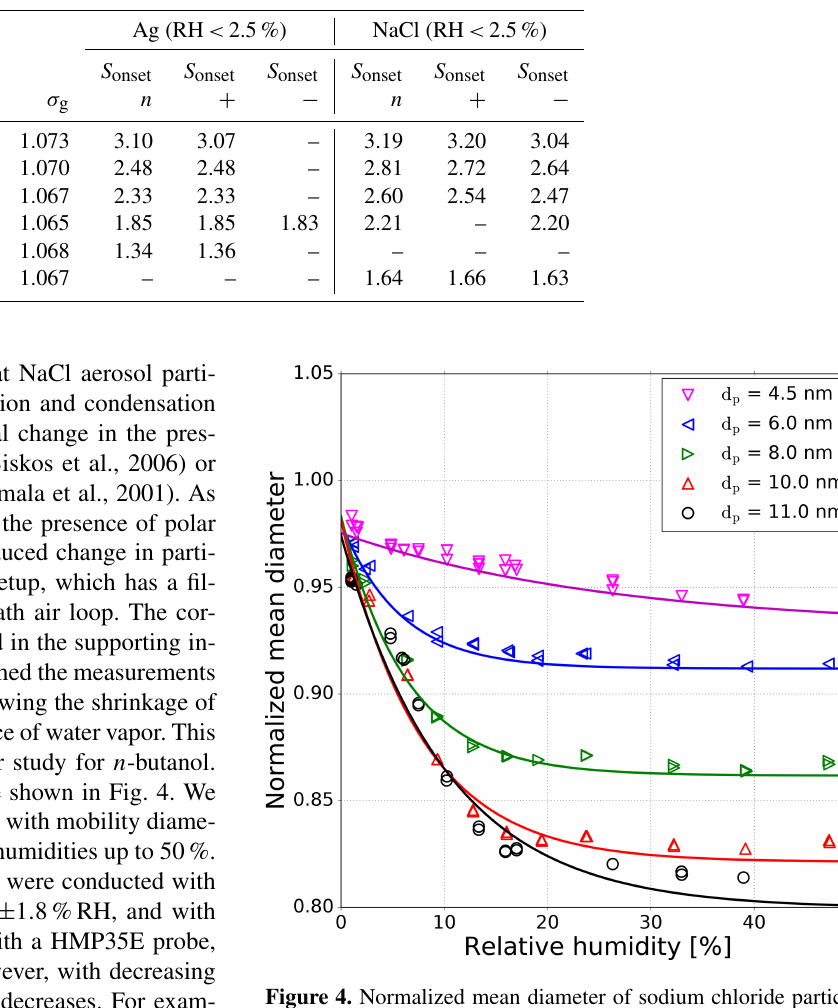
Figure 4. Normalized mean diameter of sodium chloride particles as a function of relative humidity which represents the shrinkage of NaCl seeds in the presence of water vapor. All sizes are mo- bility equivalent diameters. Each line represents a tentative three- parameter fit of an exponential decay. The measurements were con- ducted with SHT75 sensors with an accuracy of ± 1 . 8%RH and with a HMP35E probe with an accuracy of ± 2 .